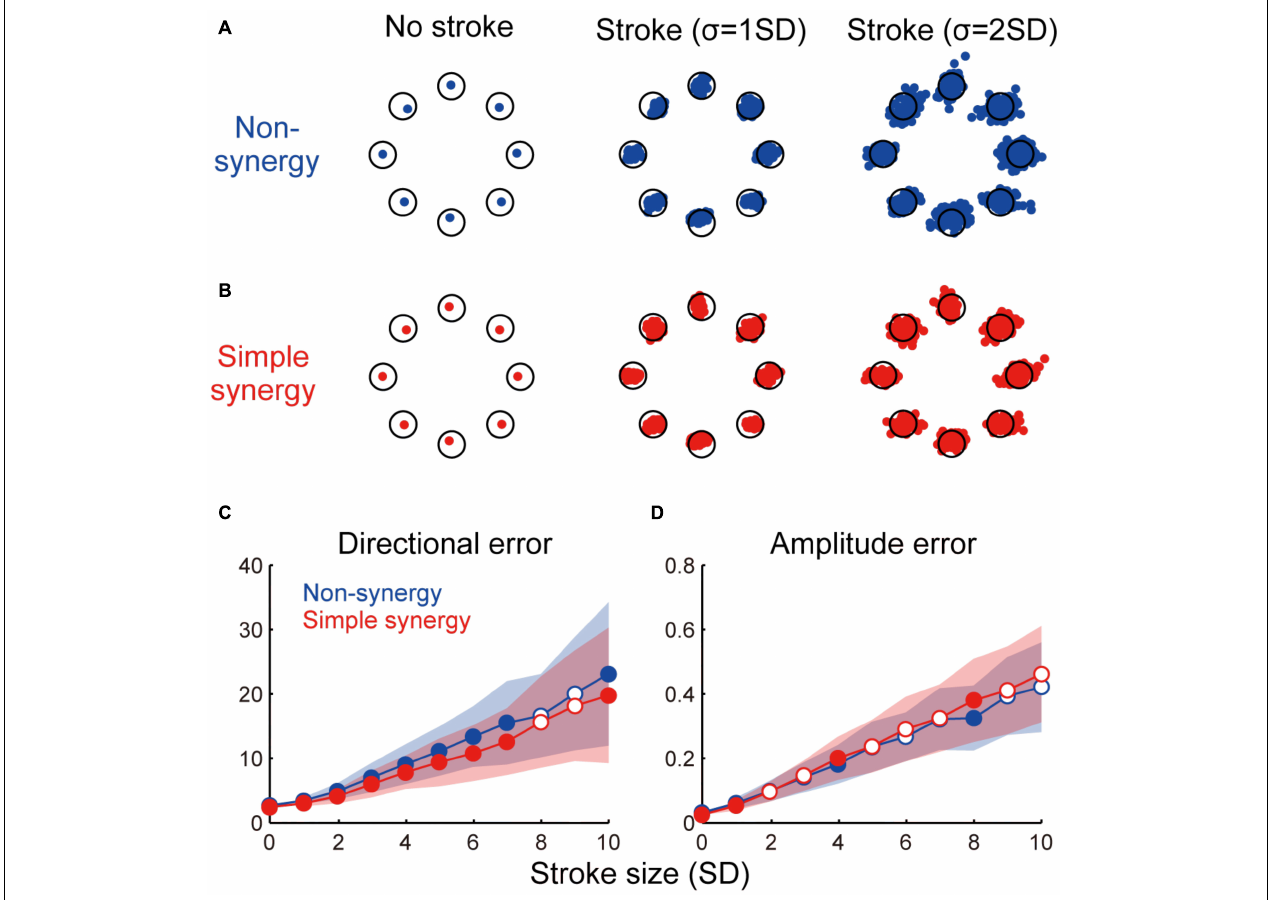
FIGURE 4 | Effect of cortical stroke on task performance. (A,B) Examples of torque output by non-synergy model (A) and simple synergy model (B) in no stroke and two different sizes of stroke ( σ = 1 and 2 SD). Each dot indicates one stroke case. Only 100 examples are plotted for visualization purpose. Open circle, target torque combination. (C,D) Size of directional error (C) and amplitude error (D) as a function of stroke size ( σ = 1–10SD). Line and shade, mean and standard deviation across 200 stroke cases. Open and filled circles indicate significant and non-significant differences between two models ( p < 0.05, bootstrap test, n =